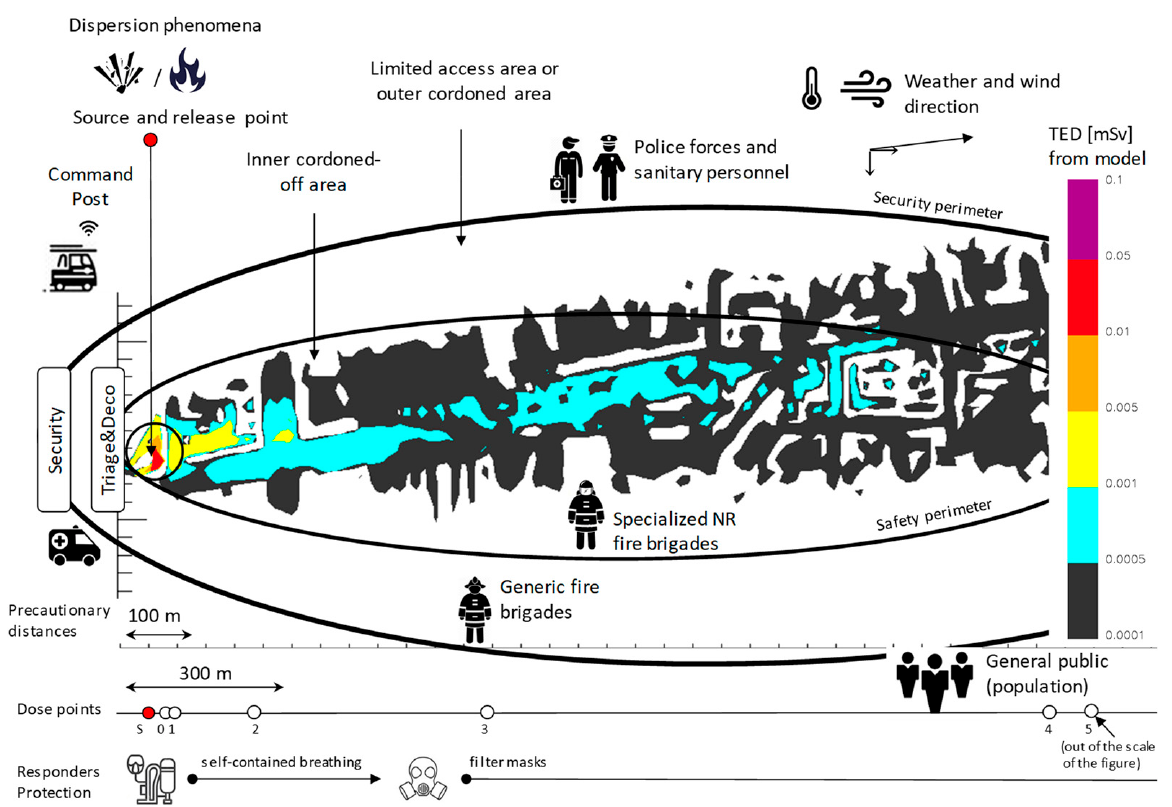
Figure 2. Representation of the areas of respect, of the protection measures to be respected in each area, and of the resources allocated by area between the entities of an RN (radiological-nuclear) emergency response.